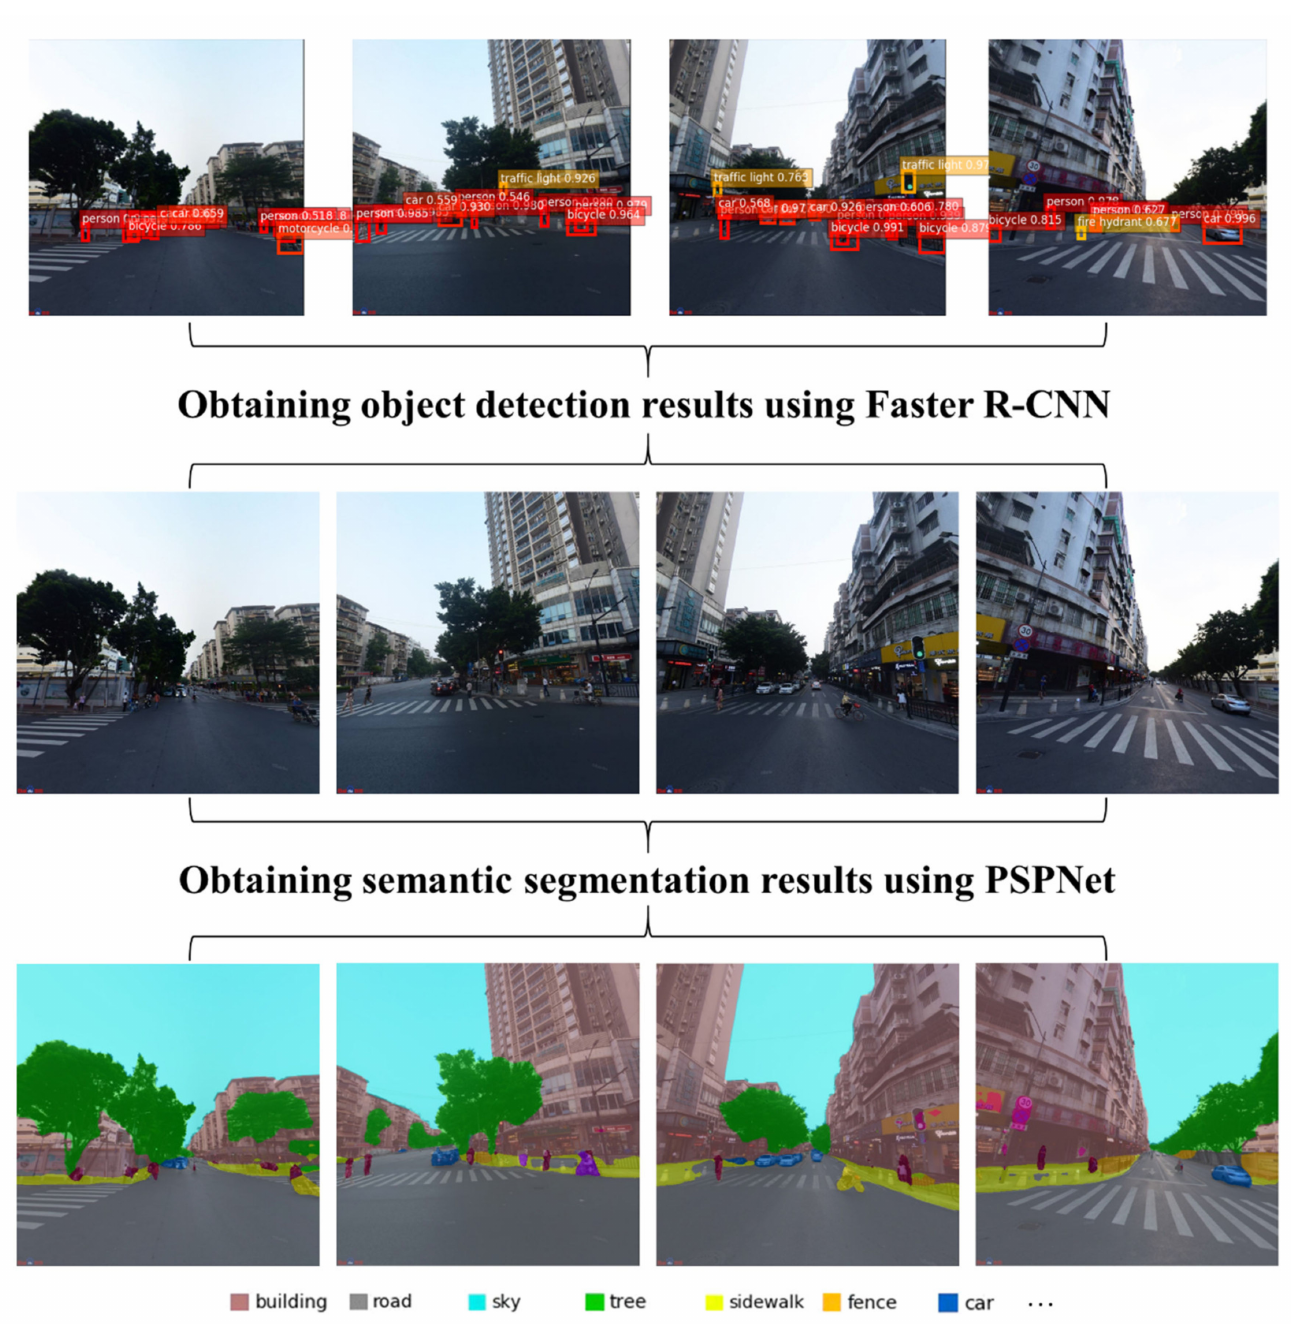
Figure 3. Obtaining object detection and semantic segmentation results of BSV images via Faster RCNN and PSPNet